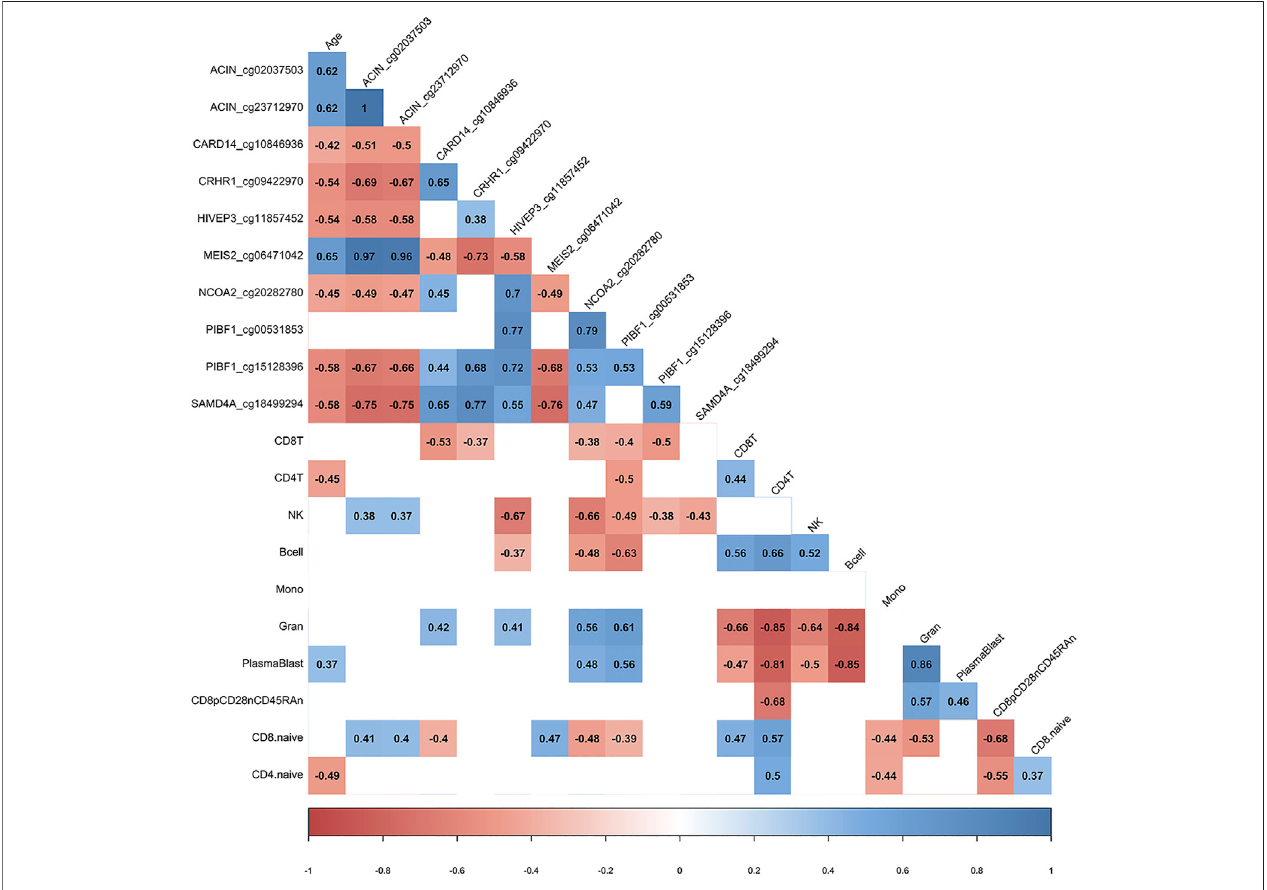
FIGURE 3 | DML associated with COVID-19 relate to immune cell type composition. Correlogram plot of biological age, the change in DNA methylation levels for COVID-19-relatedDML,andthechangeininferredimmunecelltypefollowingCOVID-19.Signi fi cantcorrelationsdisplayedassolidboxandSpearman ’ srankcorrelation coef fi cient